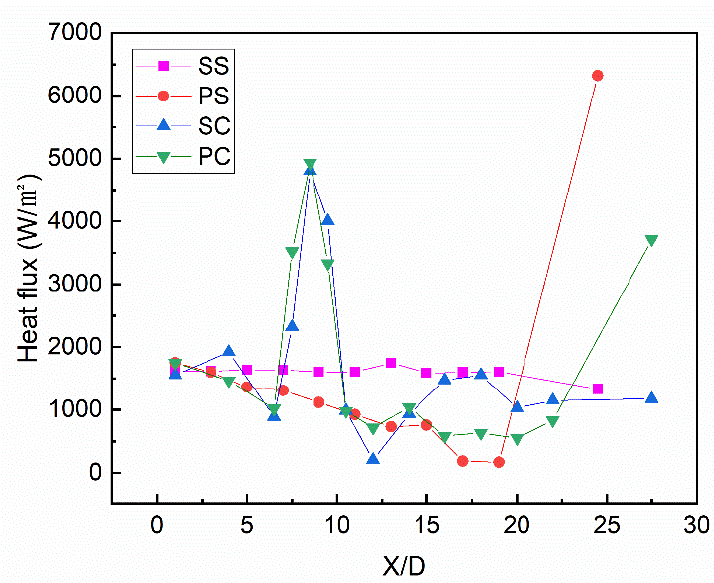
Figure 16. Heat flux of the different cross-sections of the “SS”, “PS”, “SC”, and “PC”. If the effect of reverse flow was ignored, the total heat flux from the “Inlet” to “S10” of the steady flow and the pulsating flow in the curved pipe were 8% and 65% higher than that of the straight pipe, respectively. The heat flux of the steady flow in the straight and curved pipes was 64% and 10% higher than that of the pulsating flow, respectively. It is worth noting that at the entrance of the test section, the local heat flux of the pulsating flow is higher than that of the steady flow, and the closer to the pulsation generator, the larger the temperature amplitude is and the higher the local heat flux of the pulsating flow is.